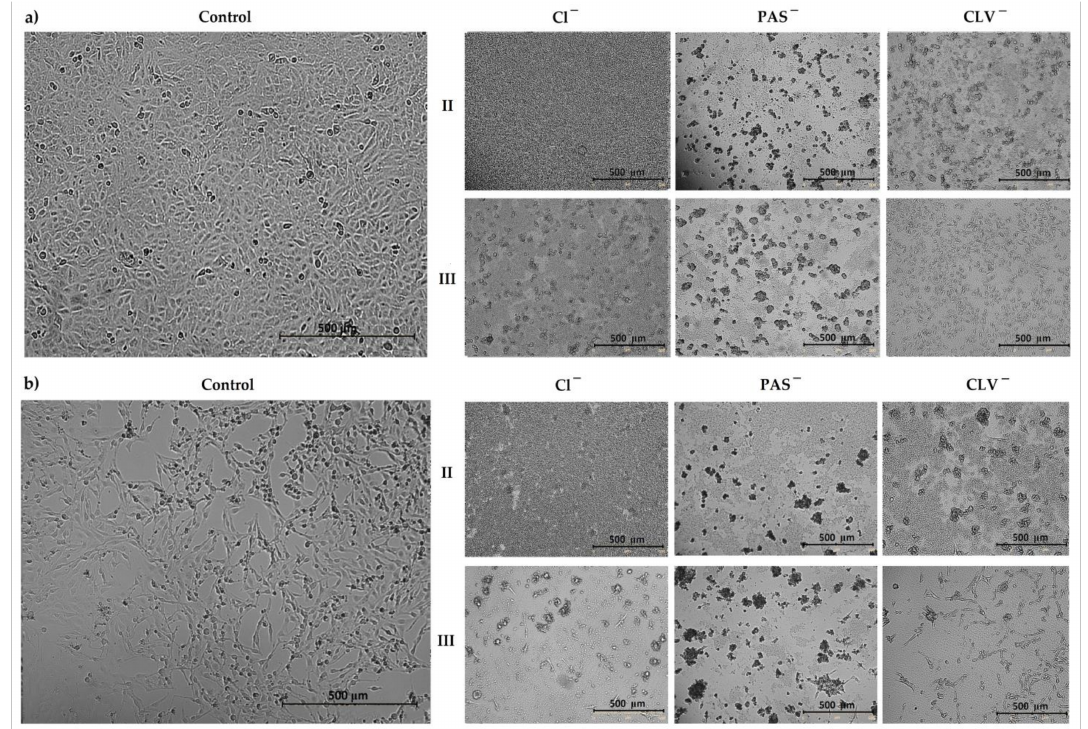
Figure 4. Microscopic images by Live Cell Analyzer for untreated control cells vs. treated ( a ) A549 and ( b ) BEAS-2B cells by polymer II and III with Cl − , PAS − and CLV − counterions. The scale bar represents 500 µ m.